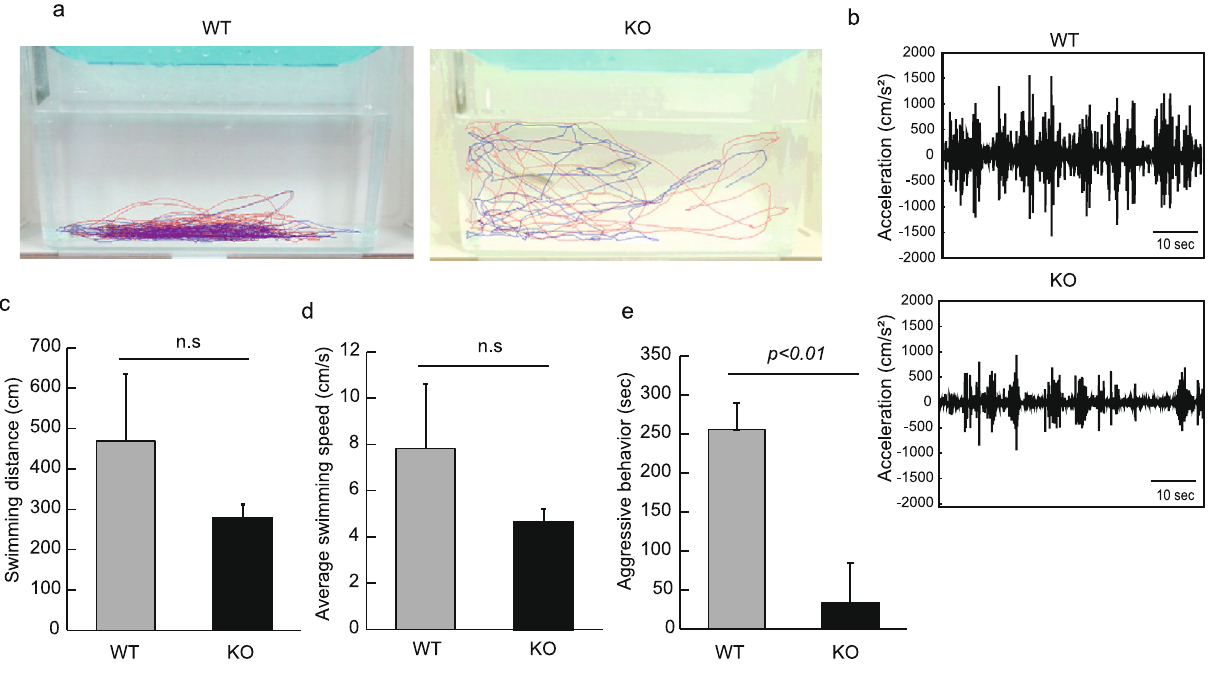
Figure 2. Analysis of aggressive behavior in Neu1-KO and WT zebrafish. Two unfamiliar male zebrafish were set in the transparent aquarium and their aggressive behavior was observed for 10 min. ( a ) Tracking of 2 males in WT and Neu1-KO. Red and blue lines indicate the swimming tracking of 2 males. ( b ) Swimming acceleration. ( c ) Swimming distance. ( d ) Swimming speed. ( e ) Aggressive behavior. n = 6 for each group. Results are shown as means ± standard deviation. All values were compared using Mann–Whitney U test. n.s., not